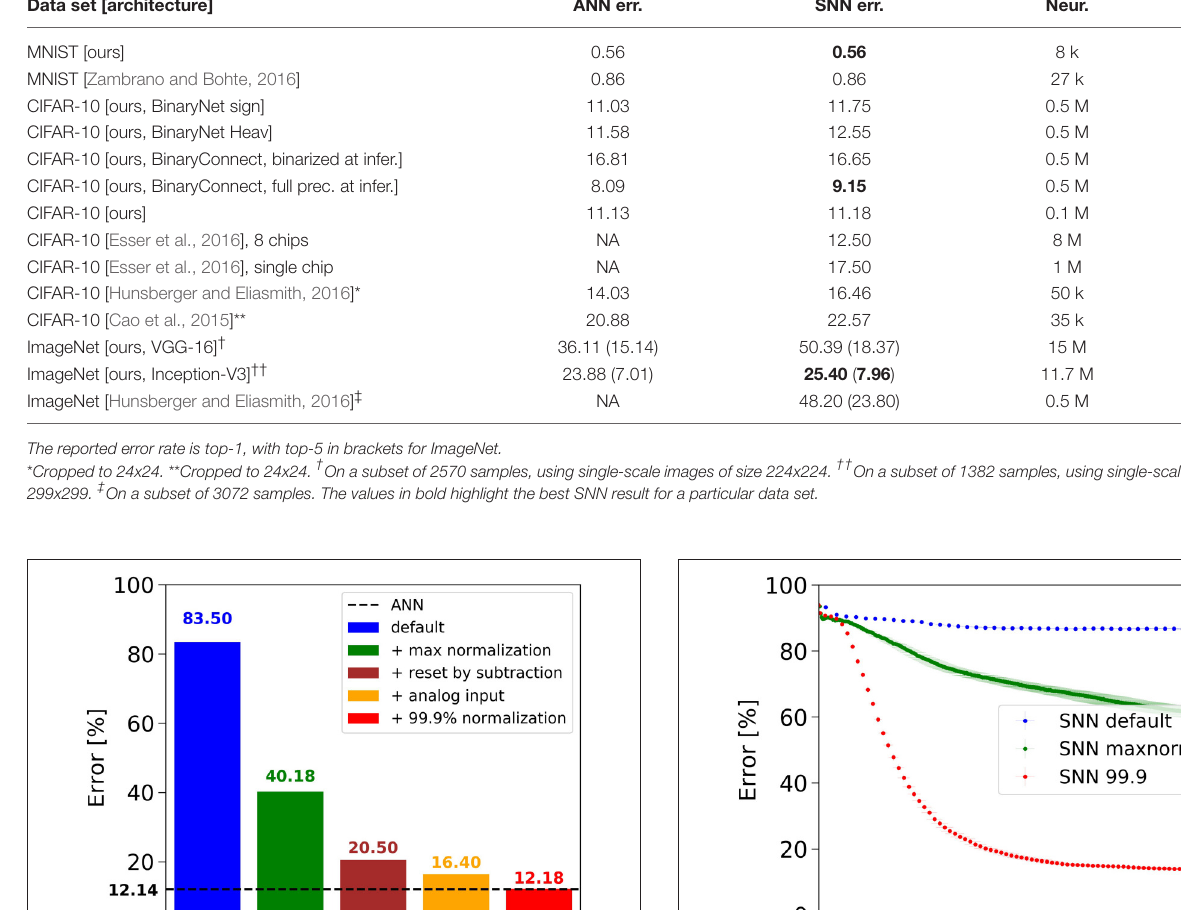
TABLE 1 | Classification error rate on MNIST, CIFAR-10 and ImageNet for our converted spiking models, compared to the original ANNs, and compared to spiking networks from other groups. Data set [architecture] ANN err.